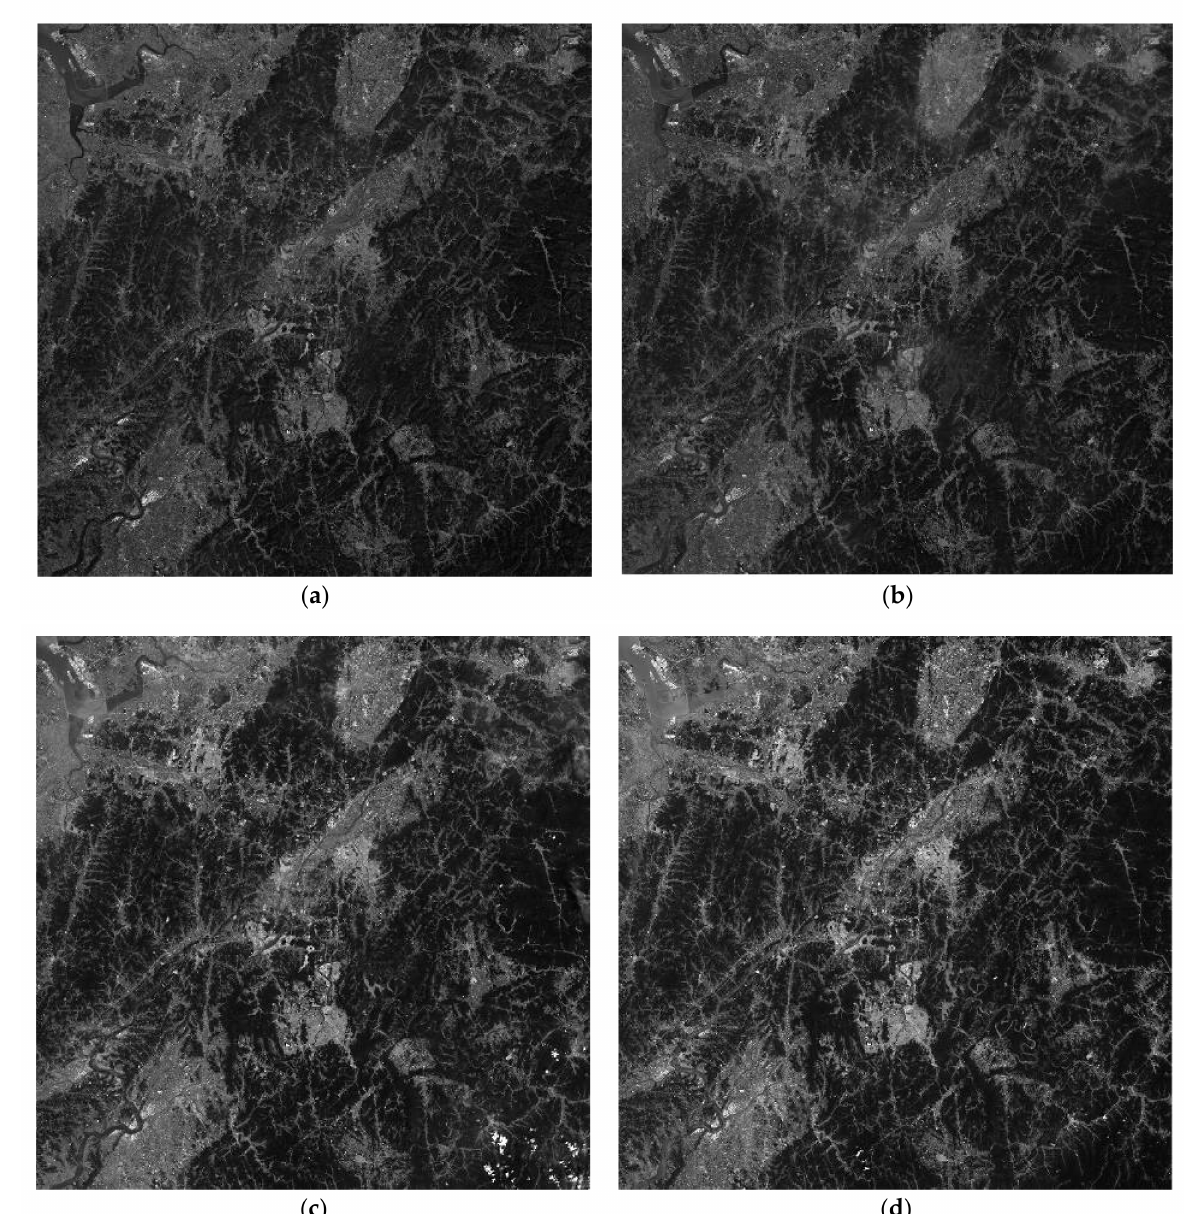
Figure 3. Acquired Sentinel-2 band number 2 (10 m) images: ( a ) Sentinel-2A 2018/04/18, ( b ) Setntinel-2A 2018/04/28, ( c ) Setntinel-2A 2018/05/28, ( d ) Setntinel-2B